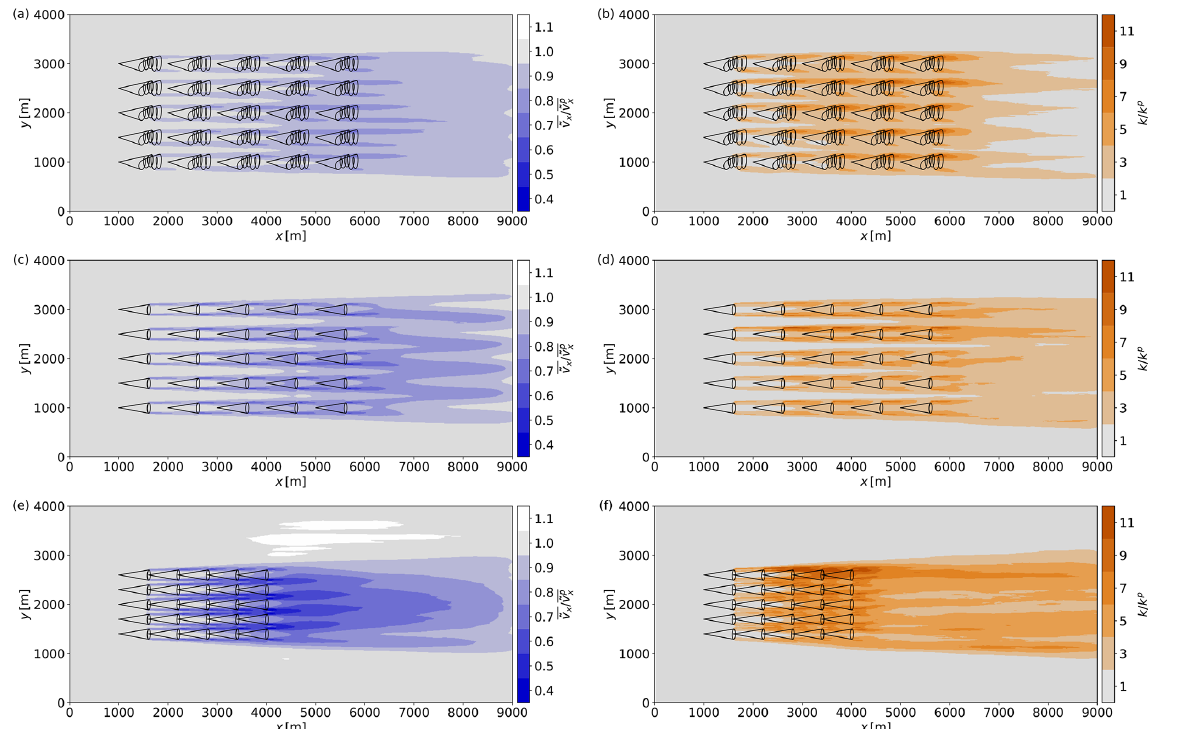
Figure 13. Mean fields of streamwise wind velocity (cid:101) v x and turbulent kinetic energy k shown in the horizontal xy plane at a height z = 200m for the AWE parks L1 (a, b) , D1 (c, d) , and D2 (e, f) . The simulation is averaged over 1h of park operation and normalised by the mean precursor values (cid:101) v p x and k p . The black lines depict the park layout by showing the horizontal footprint of the AWE system